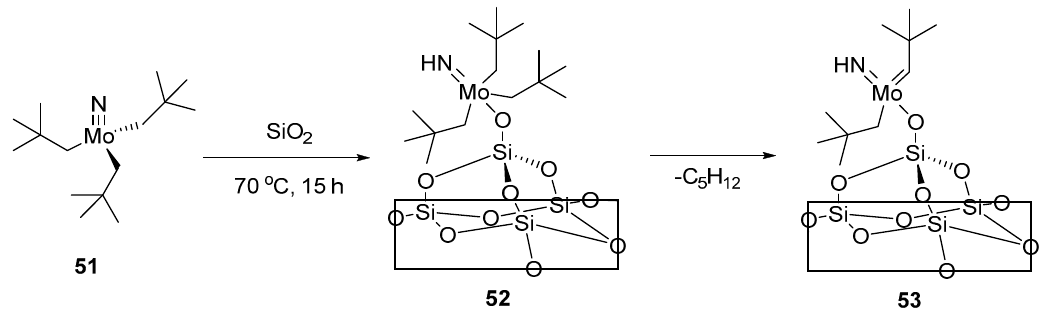
Scheme 4. Synthesis of Silica-Supported Schrock Catalyst 53